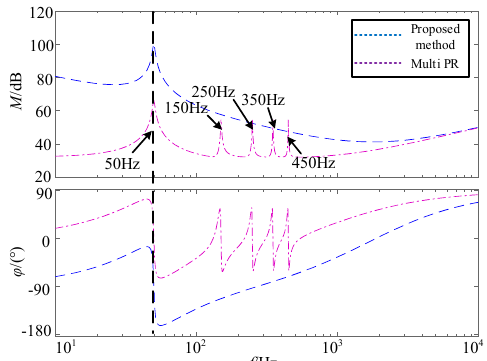
Figure 12. Proposed control loop of capacitor voltage and grid current feedback. ( a ) Optimization step I; ( b ) optimization step II; ( c ) proposed control structure, respectively.